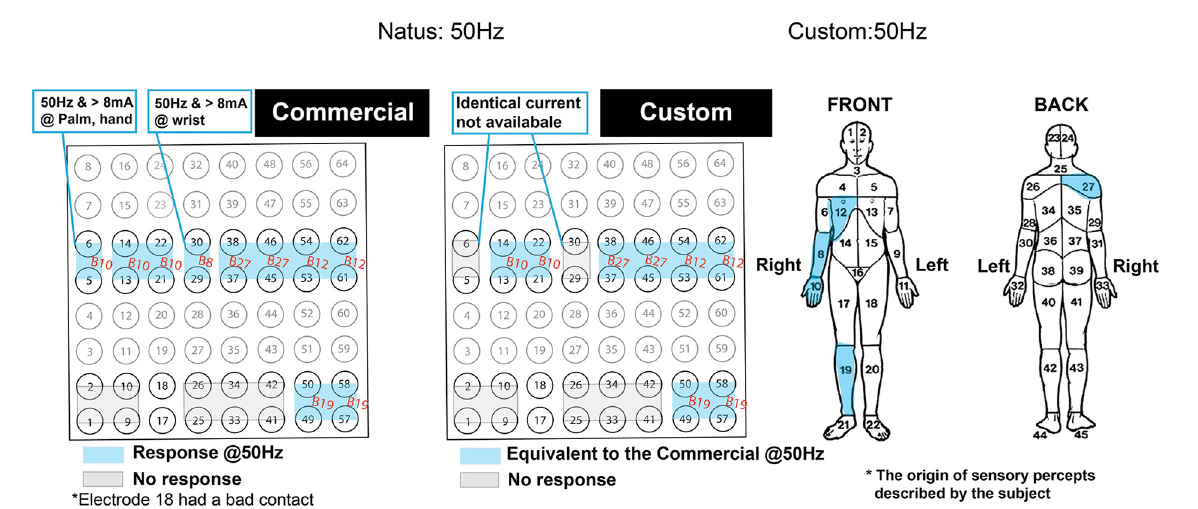
FIGURE13 Side-by-side comparison of the patient’s self-reported response from the functional brain mapping performed at 50Hz stimulation frequency. Blue highlighted regions indicate motor responses and are annotated with body region within which the response was originated. The gray zone indicates the region with no response. The response was due to 2 s of stimulation with the commercial (left) and the custom system (right) . The compartmentalized body map on the right was used as a reference for the annotated body regions. The orientation of the grid is displayed to match the Figure